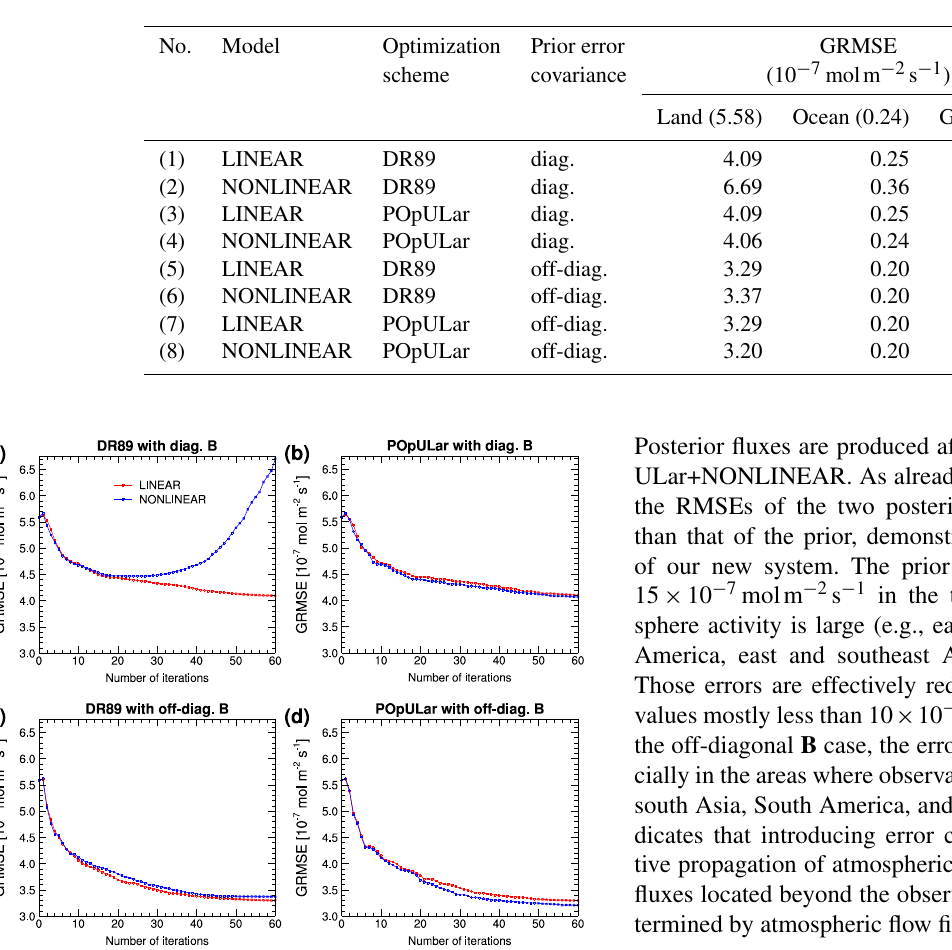
Table 2. List of the eight sensitivity tests and the global root mean square errors (GRMSE) of each posterior flux for the global land, the global ocean, and the global total. The numbers in parenthesis are those of the prior flux.